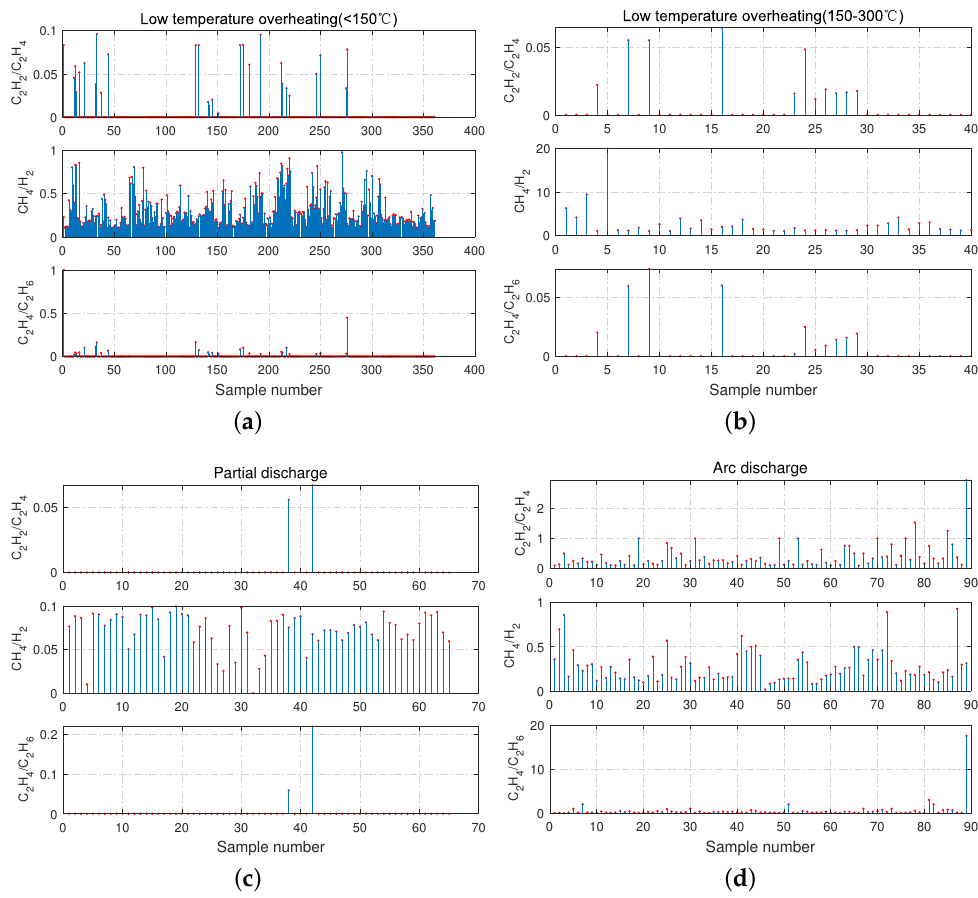
Figure 4. Dissolved gas data distribution of three-ratio for four fault types. Figure 4. The Dissolved gas data distribution of three-ratio for four fault types. ( a – d ), in the order of low temperature overheating (<150 °C), low temperature overheating (150–300 °C), partial discharge, and arc